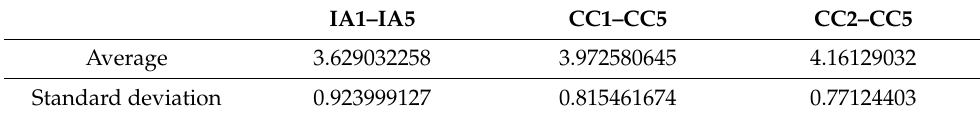
Table 9. Averages of the mean and standard deviation values between data